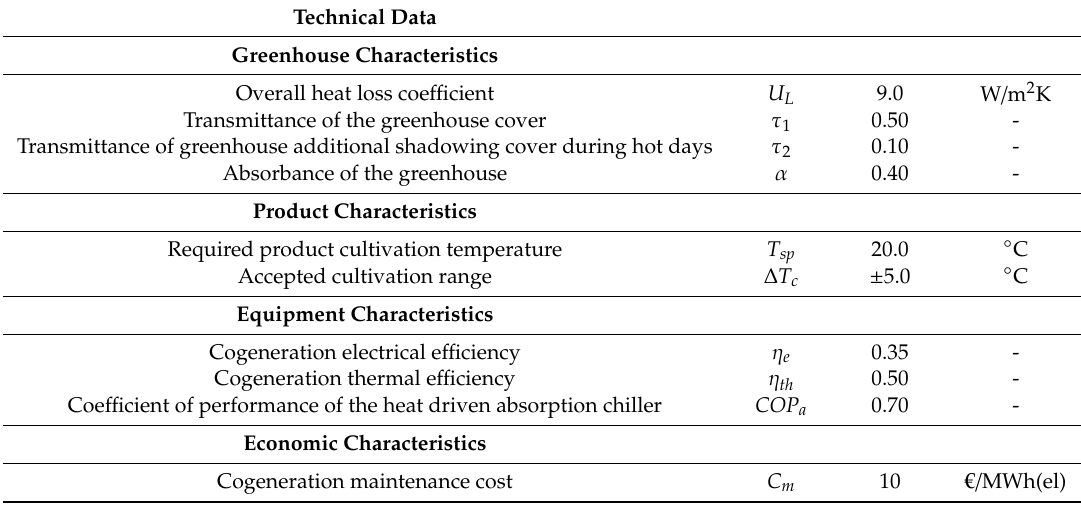
Table 1. Summary of technical data used in the mathematical